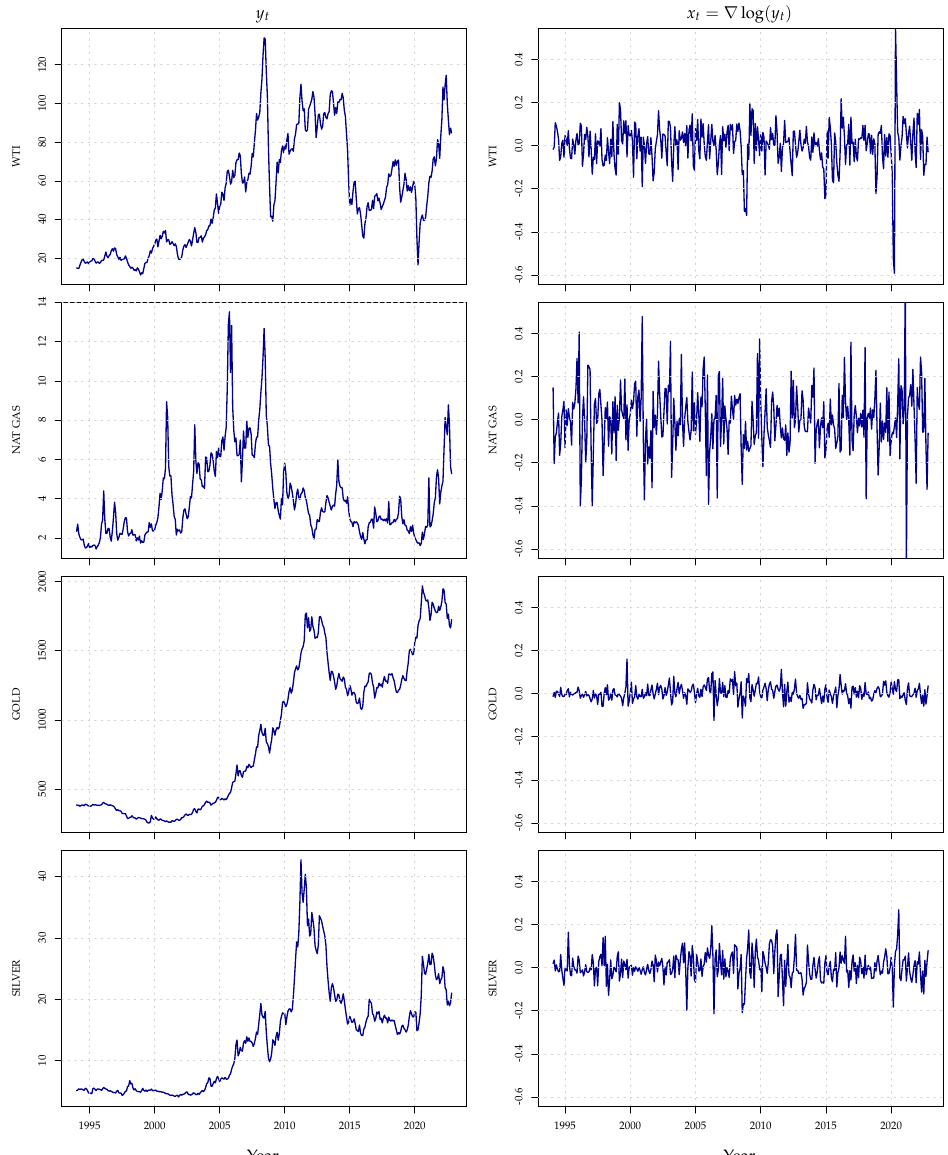
Figure 16. Time plots of the four monthly commodities series January, 1994–November, 2022. Left column: raw commodities y t . Right column: log-returns x t = ∇ log ( y t )